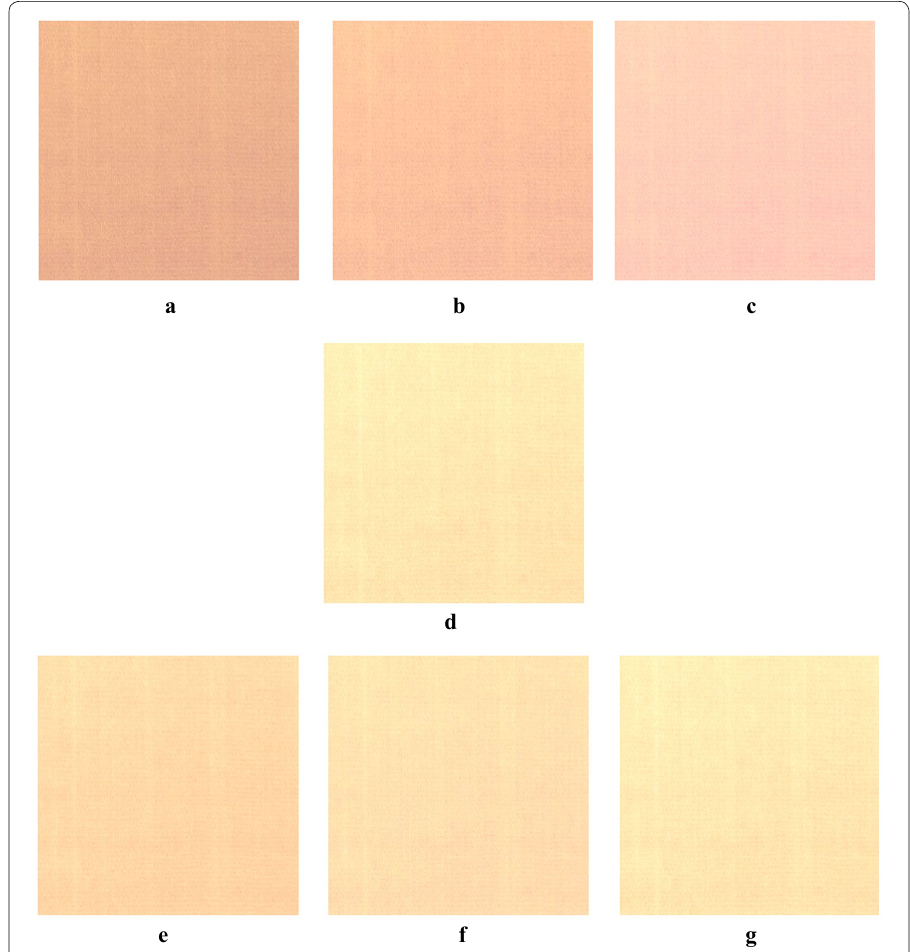
Fig. 8 Unmordanted, calcium chloride and alum mordanted B. ferruginea dyed cotton fabric. a CaCl 2 pre-mordanted dyed fabric, b CaCl 2 post-mordanted dyed fabric, c CaCl 2 meta- mordanted dyed fabric, d unmordanted dyed fabric, e alum pre-mordanted dyed fabric, f alum post-mordanted dyed fabric, g alum meta-mordanted dyed fabric